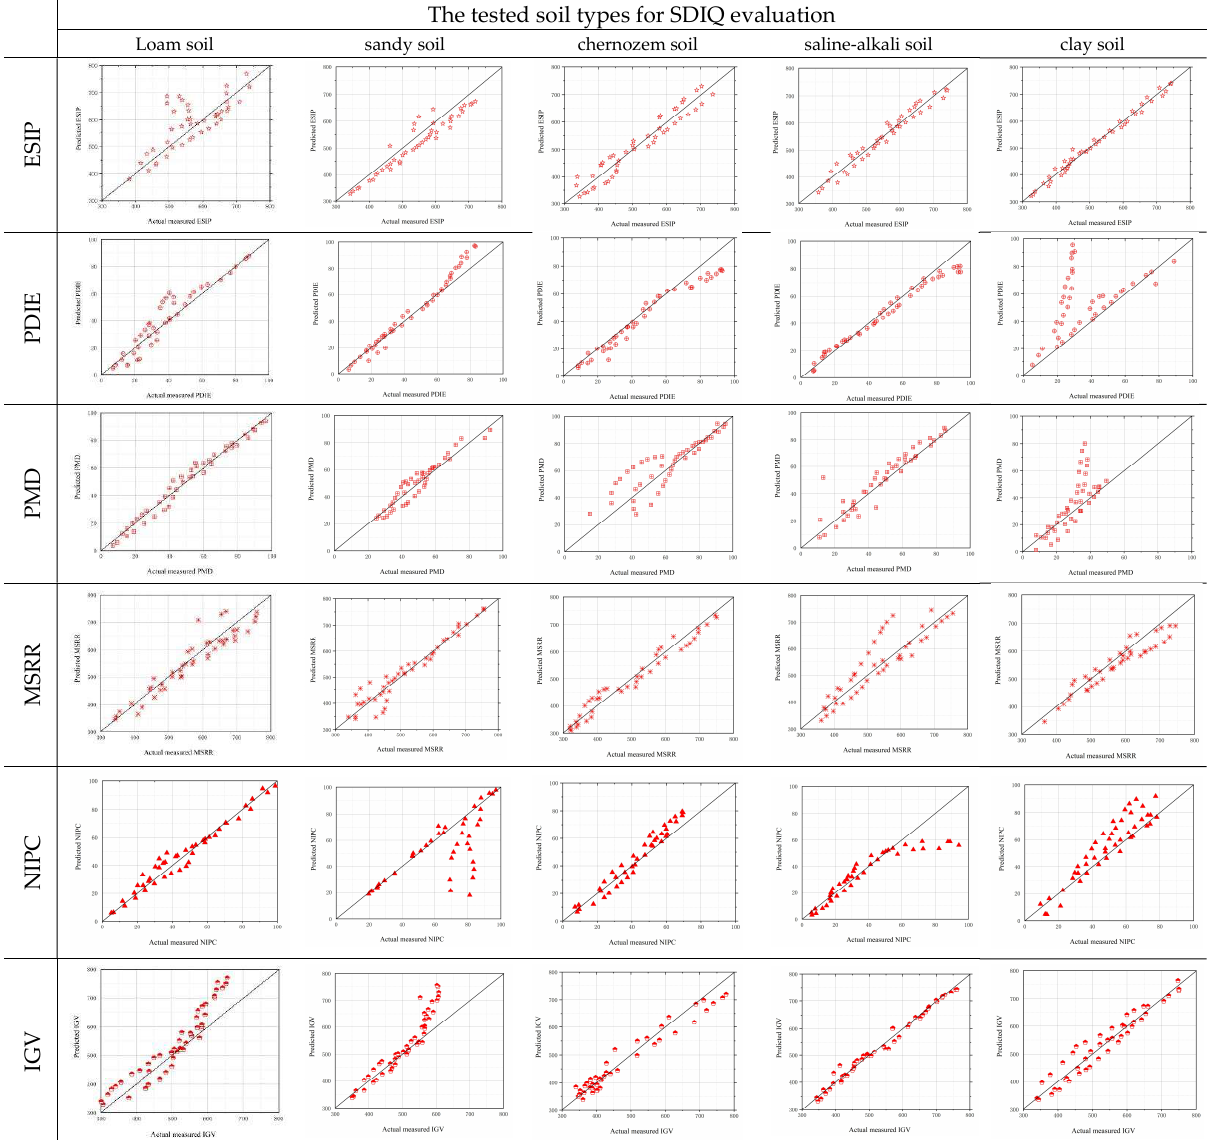
Figure 15. Accuracy comparison between the actual measured and predicted SDIQ indices considering soil types.